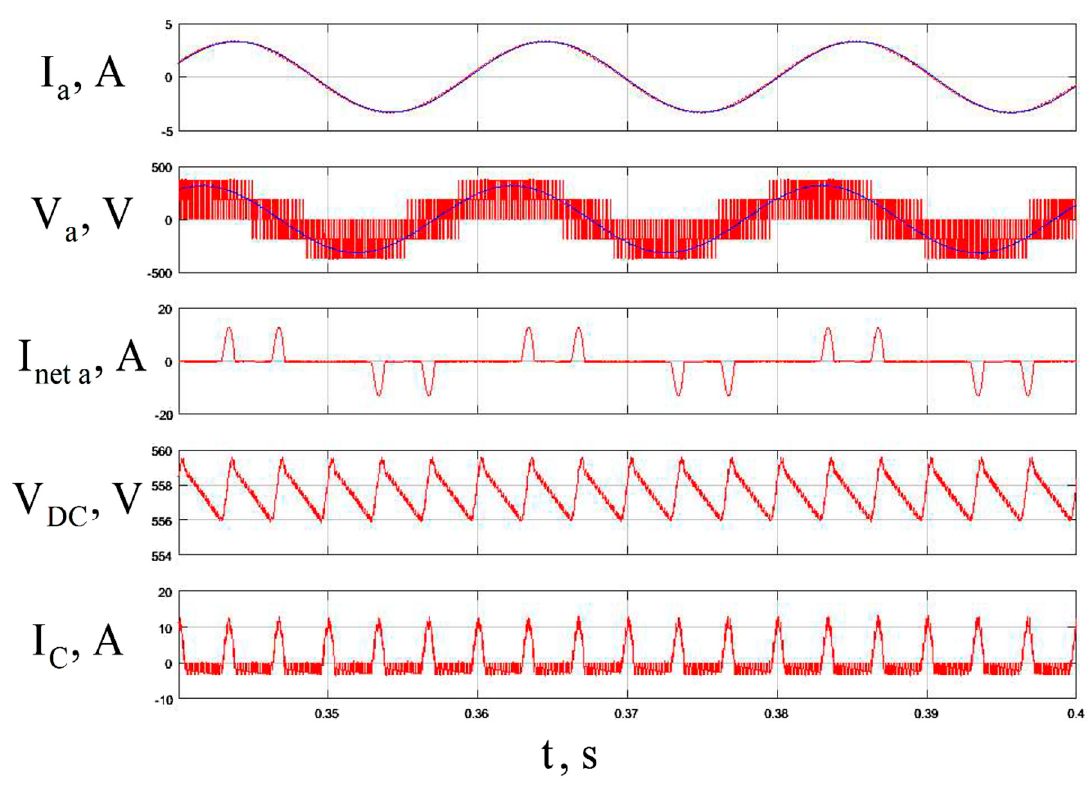
Figure 8. Waveforms of currents and voltages of CDM (Simulink